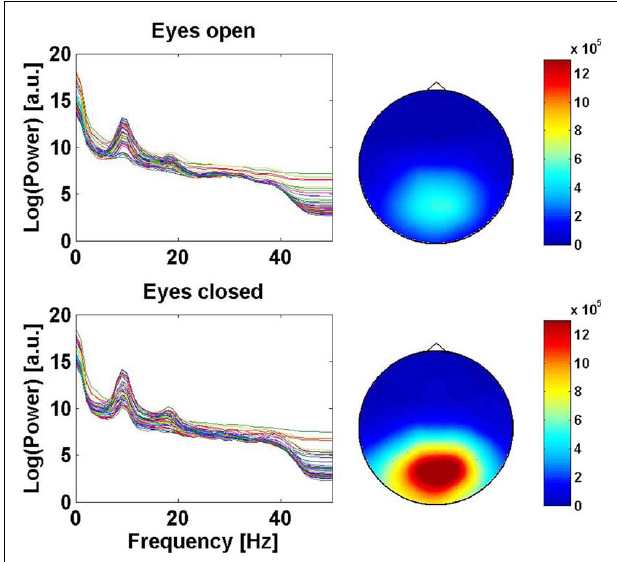
FIGURE 8 | (Data Set 1 – artificial). Left: spectra of the signal at all channel locations for the two conditions, eyes open and eyes closed. Right: scalp plot of the signal power at 10Hz for the two conditions (eyes open and closed).The actual noise of the artificial data varied linearly in time between both conditions, depending of the task of the BCI user.